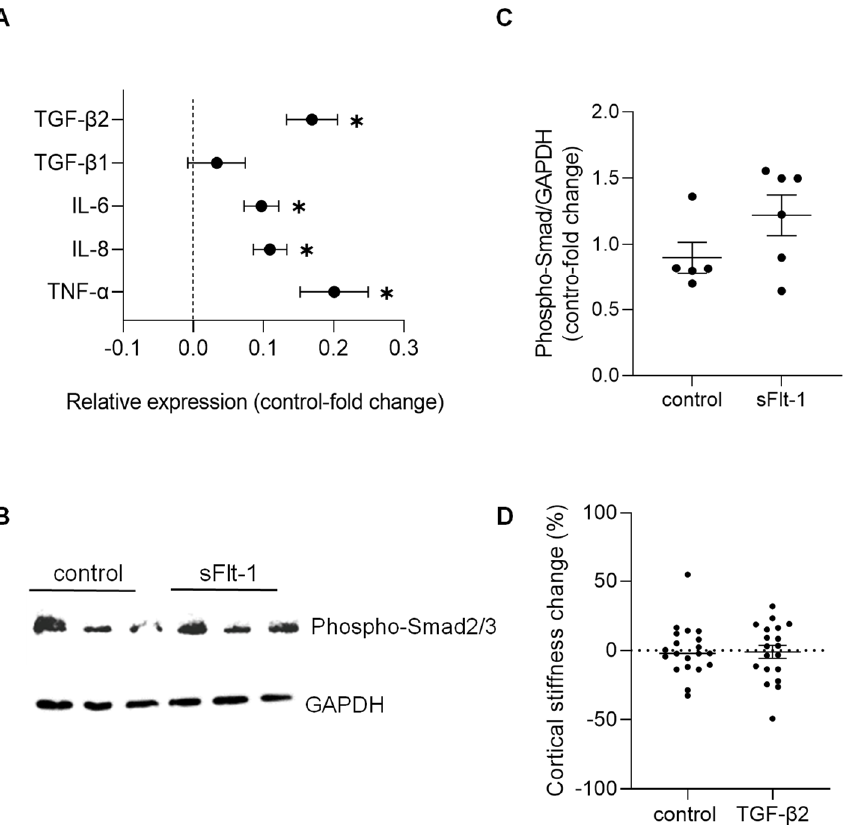
Figure 4. Gene expression and factors associated with excess sFlt-1. Primary HUVECs were treated with sFlt-1 or control protein (2 µ g/mL) for 24 h. ( A ) Gene expression analysis was measured by real-time PCR. Results are log-transformed. ( B ) Representative Western blotting image of phospho- rylated Smad2/3, the major effector of the TGF- β pathway. GAPDH was used as a loading control. ( C ) Relative densitometric analysis based on two independent experiments. ( D ) Lack of effects of TGF β 2 on endothelial stiffness. Primary HUVECs were treated with recombinant TGF β 2 (10 ng/mL) or vehicle for 24 h, and stiffness was measured by atomic force microscopy. Data are given as fold- change relative to control and are expressed as mean ± SEM. * p < 0.05. IL-6, interleukin-6; IL-8, interleukin-8; TGF β , transforming growth factor- β , TNF- α , tumor necrosis factor- α .